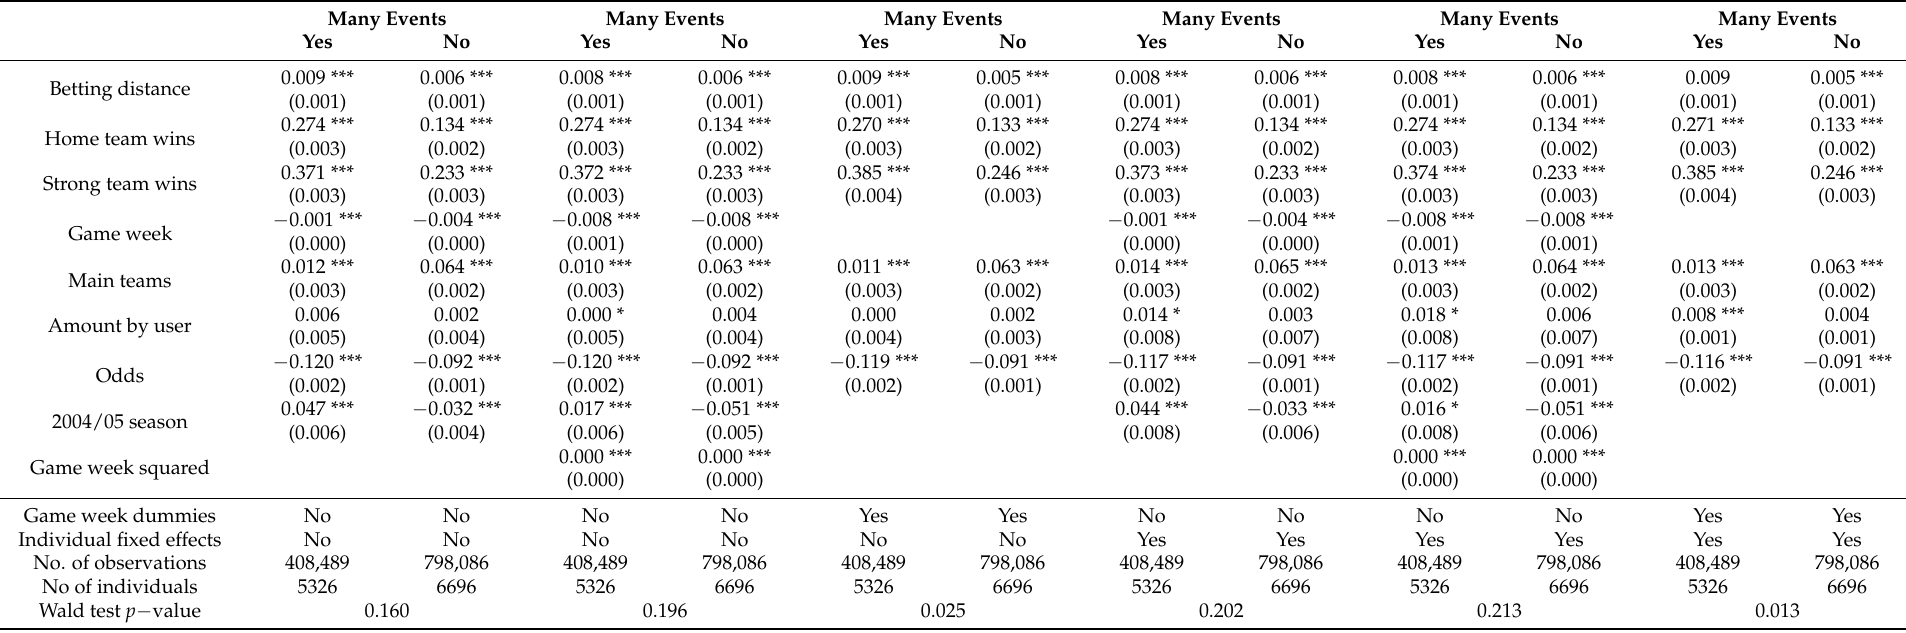
Table 2. Heterogeneity: bets linked to many events vs.